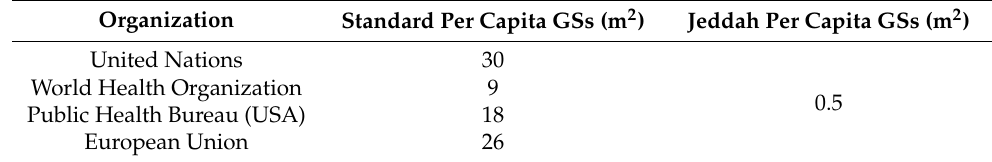
Table 3. Per capita availability of GS in